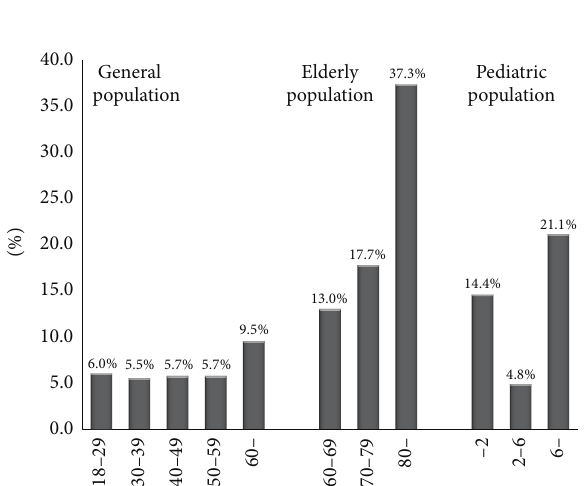
Figure 1: Age difference in the prevalence of constipation. Preva- lence of constipation was the lowest in people aged 30–39 years old in general population and prevalence of constipation increased with age for people older than 30 in general population and elderly population. Children aged 2–6 years had the lowest prevalence of constipation and older than 6 years had the highest prevalence in pediatric